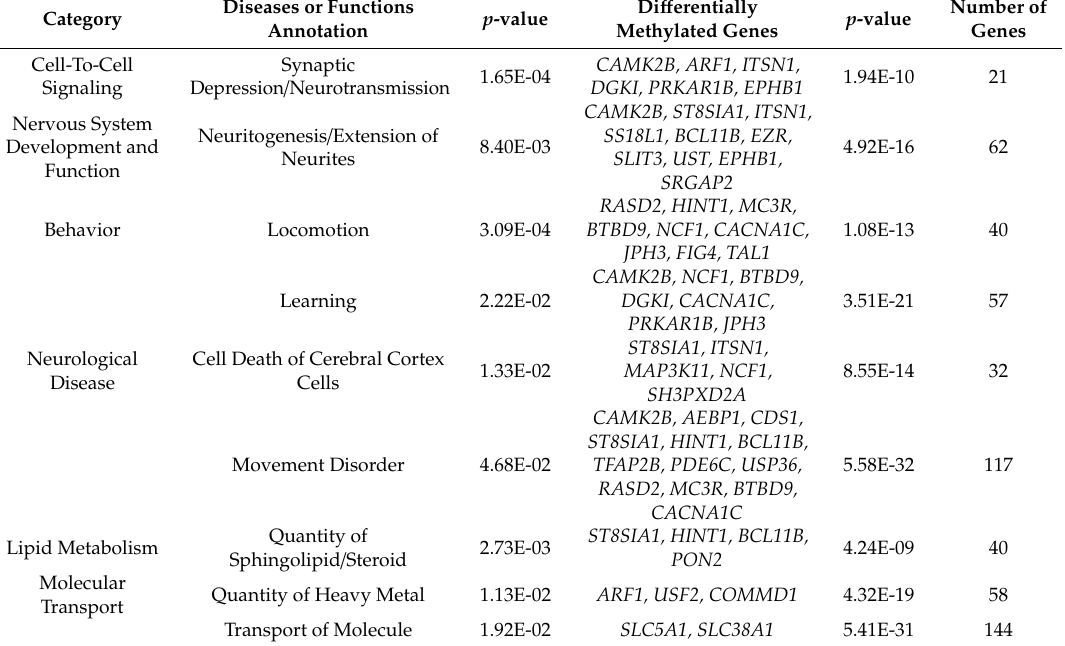
Table 4. IPA annotated functional similarity between the DNA methylome and transcriptome of the P15 ID rat